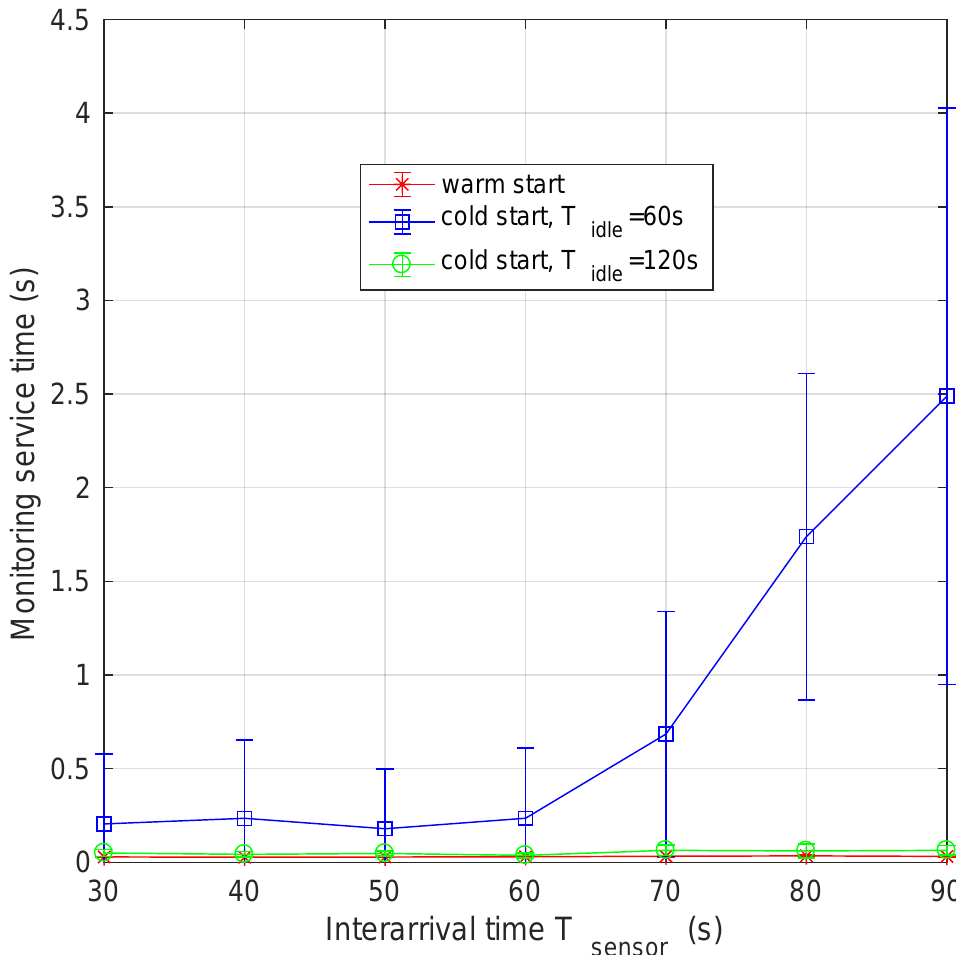
Figure 12. Monitoring time as a function of data interarrival period for both warm start and cold start, with T idle equal to 1 and 2 min. As shown by the green curve, for T idle values larger than data interarrival time, pods are always active, precluding cold start mode